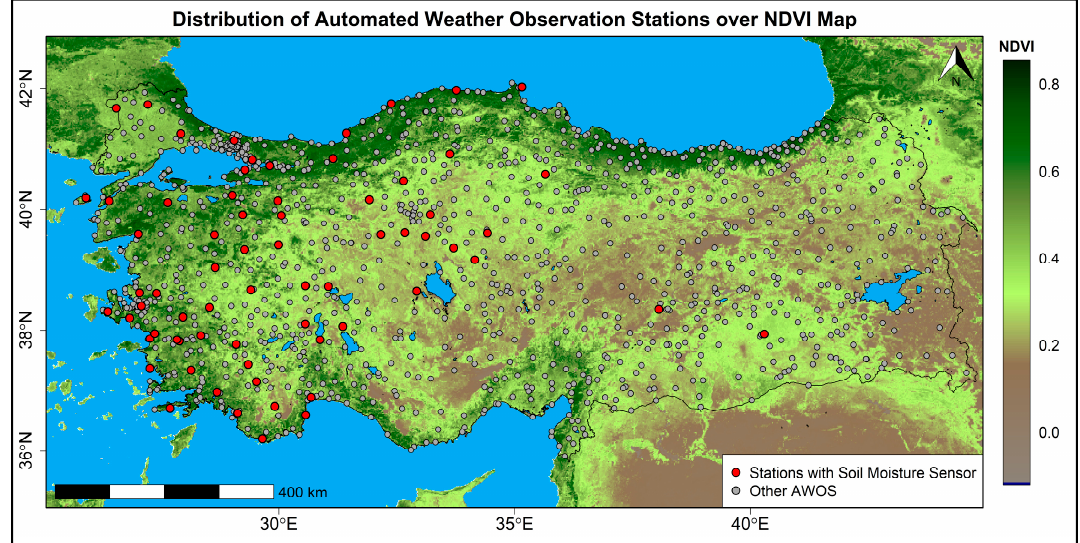
Figure 1. Distribution of automated weather observation stations (AWOS) over Normalized Difference Vegetation Index (NDVI), while the red circles show the locations of the stations measure soil moisture and used in this study.